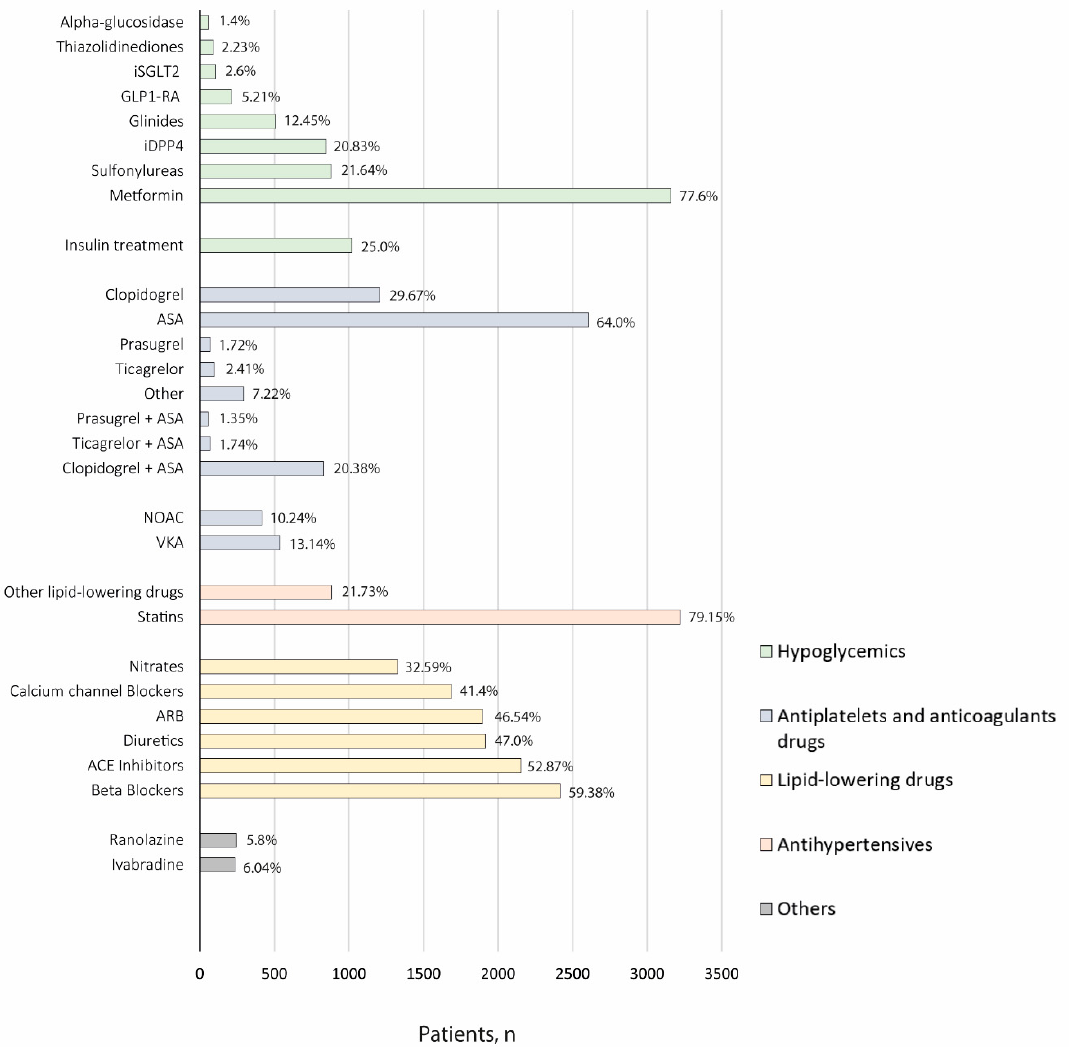
Figure 2. Pharmacological treatment of the study population at index. ACE: Angiotensin-converting enzyme; ARB: Angiotensin II receptor blockers; GLP1-RA: Glucagon-like peptide-1 receptor agonists; iDPP4: Dipeptidil peptidasa-4 inhibitors; iSGLT2: Sodium-glucose cotransporter-2; NOAC: Non- vitamin K antagonist oral anticoagulants; VKA: Vitamin K